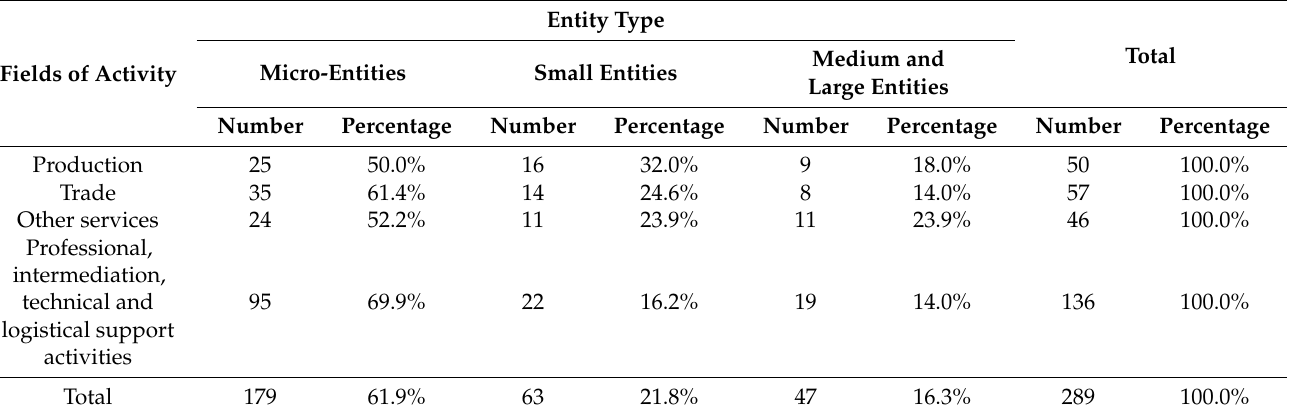
Figure 4. Sample structure by position/function. The respondents carried out the activity and made decisions for 179 micro-entities (61.94%), 63 small entities (21.80%), and 47 medium and large entities (16.26%) distributed on fields of activity highlighted in Table 1. Table 1. Crosstabulation between entity type and field of